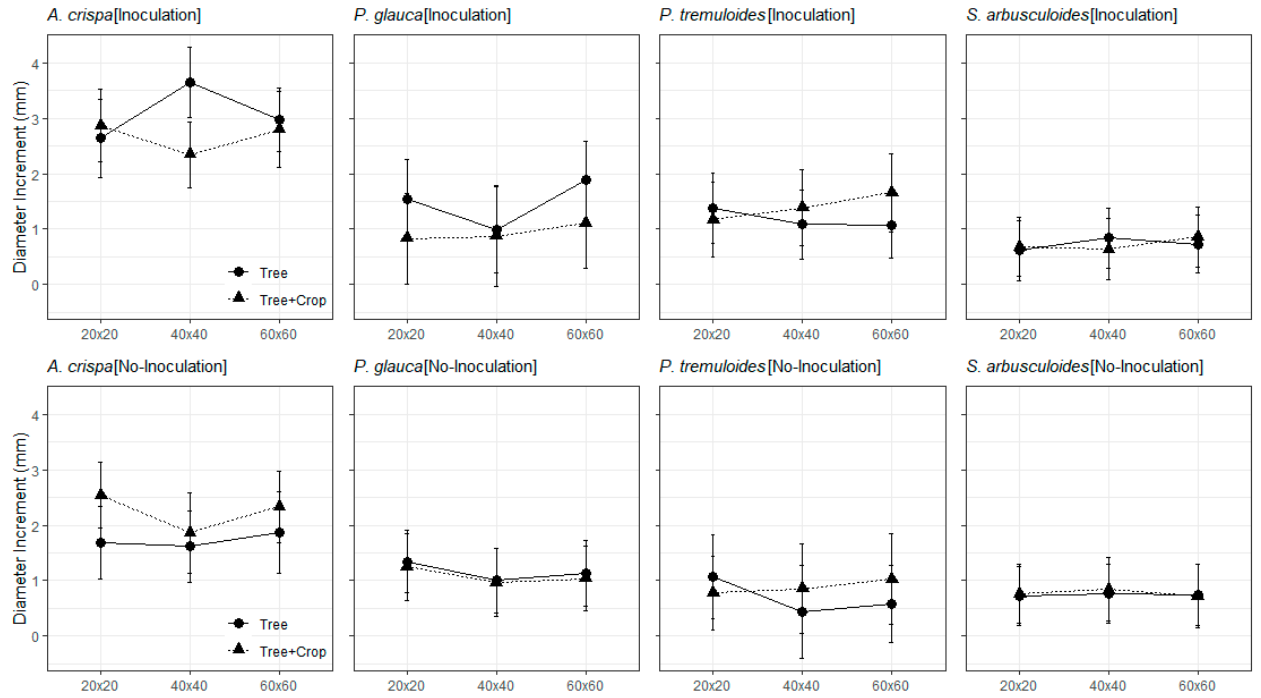
Figure 8. The interaction effect of inoculation, tree-crop, and spacing treatments in the fine tailing site. The error bars represent the 95% con fi dence interval (CI) of means.